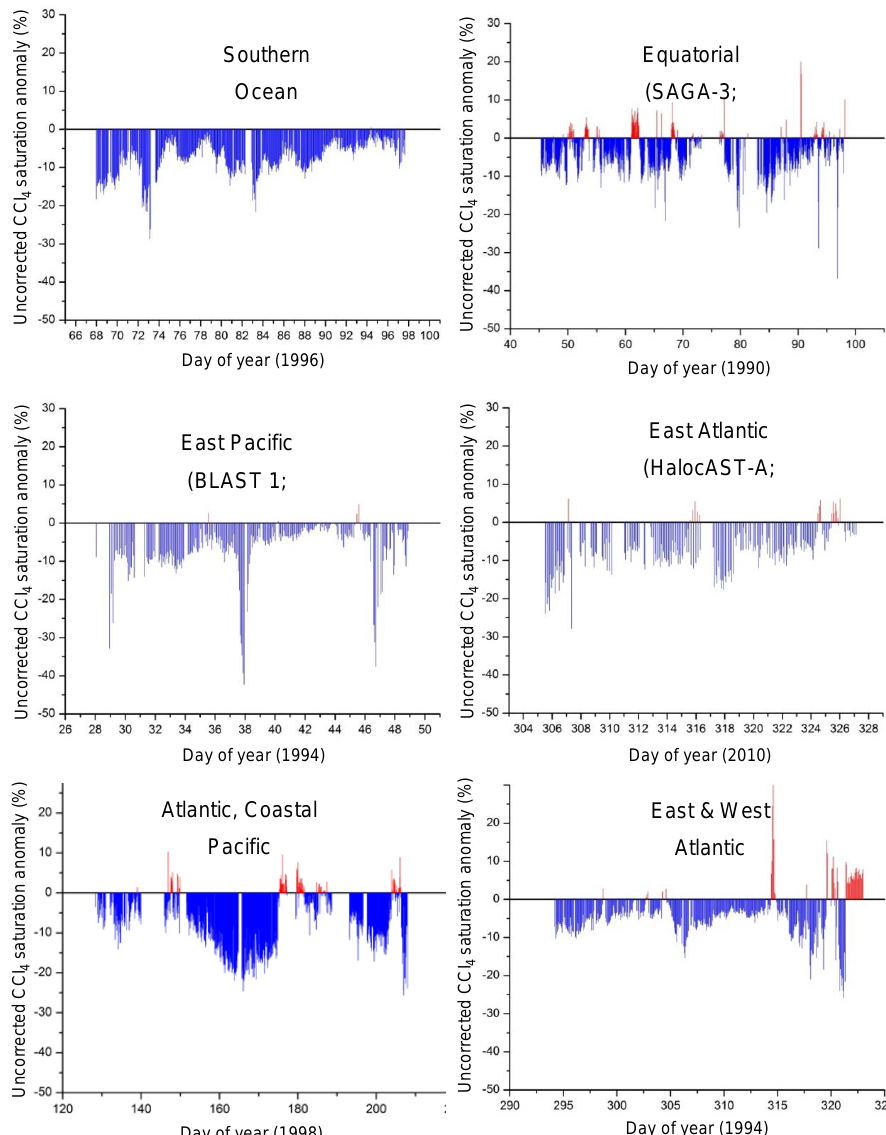
Figure 3. Regionally representative examples of observed (i.e., uncorrected) CCl 4 undersaturations from six cruises. Corrections for physical effects can alter these anomalies in either direction, but largely make them more negative by 1–3%. Negative saturations are indicated with blue lines, positive with red